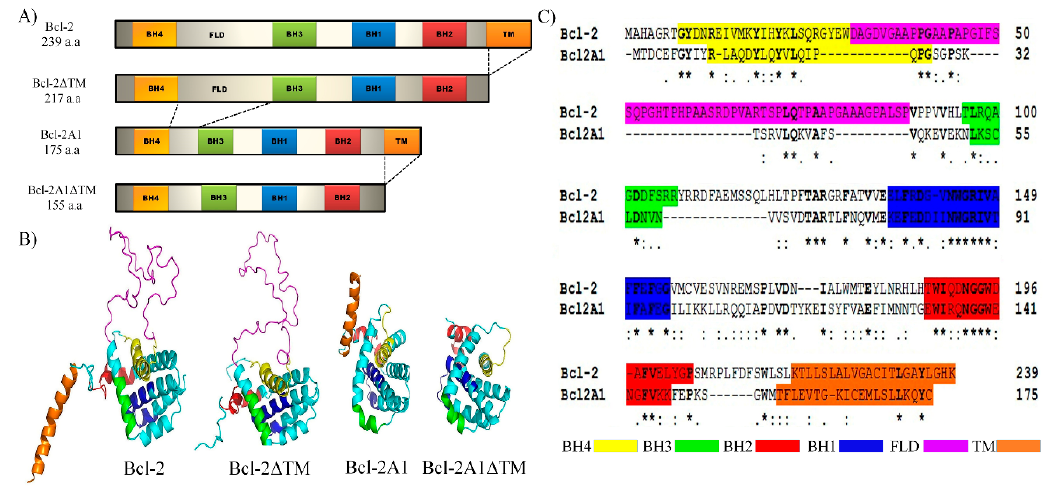
Figure 1. Sequence and structure of Bcl-2 constructs. ( A ) Domain architecture of Bcl-2, Bcl-2 ∆ TM, Bcl-2A1, and Bcl-2A1 ∆ TM constructs used in this study. ( B ) Three-dimensional structure of Bcl-2 (Bcl-2, Bcl-2 ∆ TM, Bcl-2A1, and Bcl-2A1 ∆ TM). ( C ) Clustal sequence alignment of Bcl-2 and Bcl-2-A1. In all cases, domains are colored as indicated.